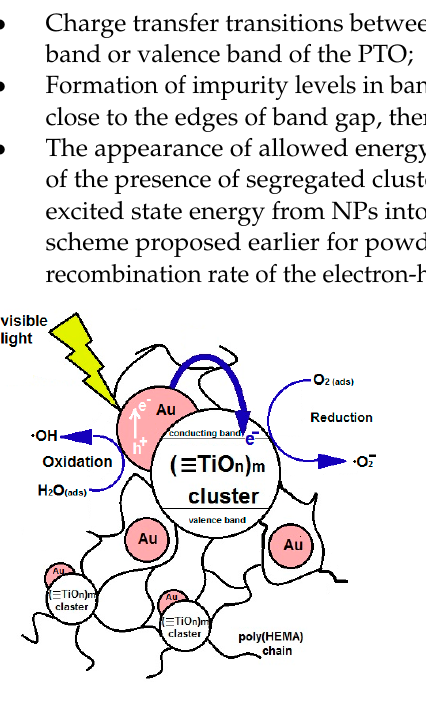
Figure 14. Schematic diagram of possible processes occurring in organic–inorganic copolymers containing nanostructured PTO modified with Au NPs under the action of visible light.